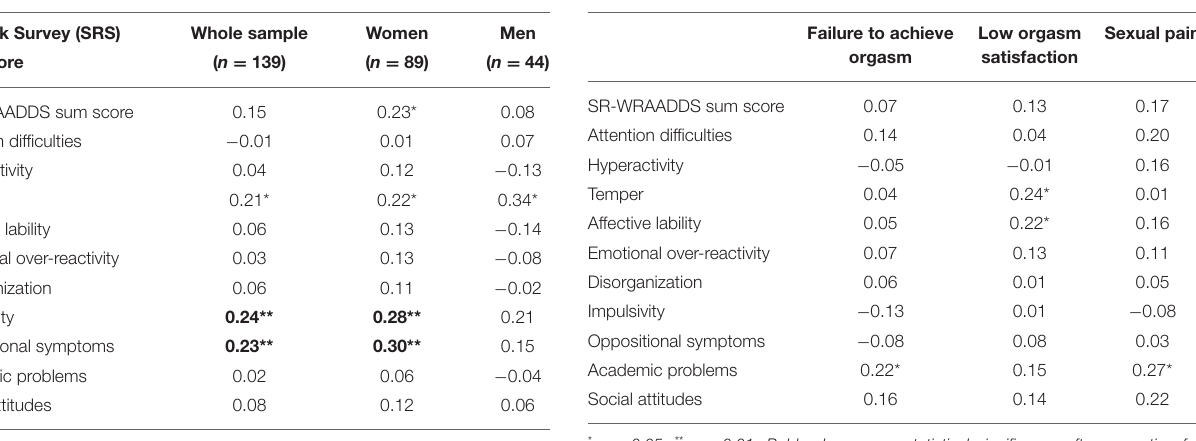
TABLE 9 | Association between ADHD symptoms and sexual dysfunctions in women with ADHD using the SR-WRAADDS and the